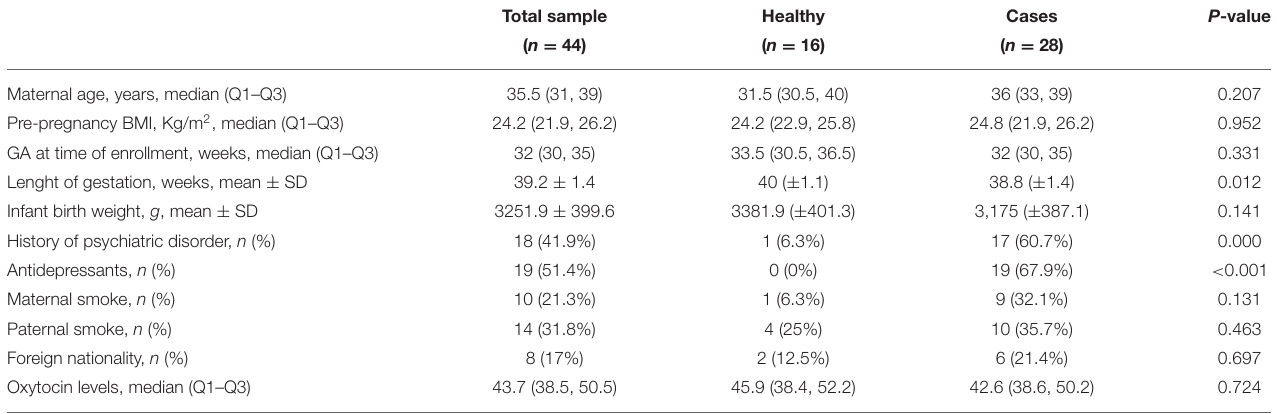
TABLE 1 | Demographic and clinical characteristics of the 44 pregnant woman. Total sample Healthy Cases P